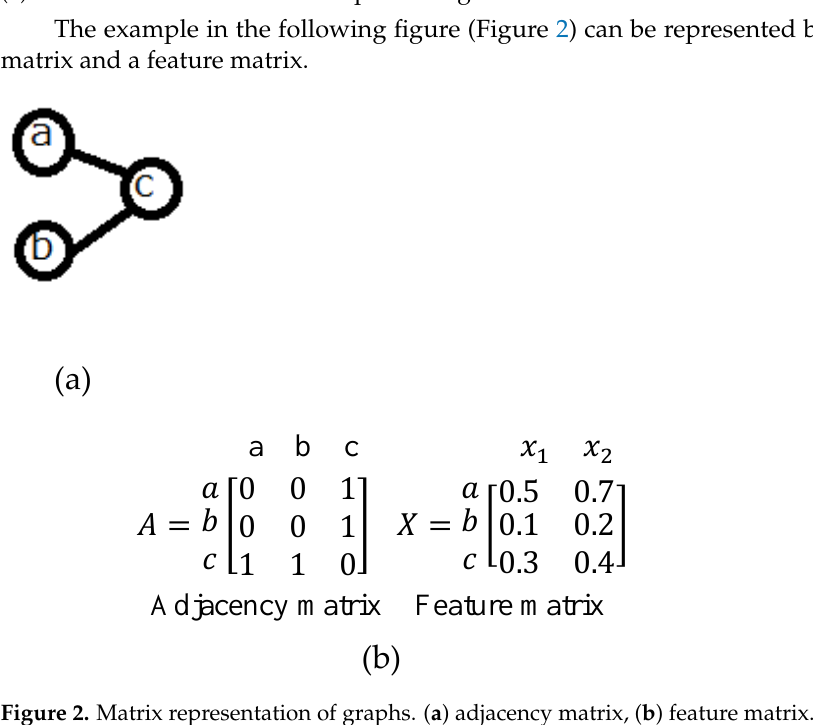
Figure 2. Matrix representation of graphs. ( a ) adjacency matrix, ( b ) feature matrix. Orange letters represent each node. For example, in the adjacency matrix, the third column of the first row contains 1 because node “a” and node “c” are connected. In the feature matrix, x 1 and x 2 indicate features, as shown in Figure